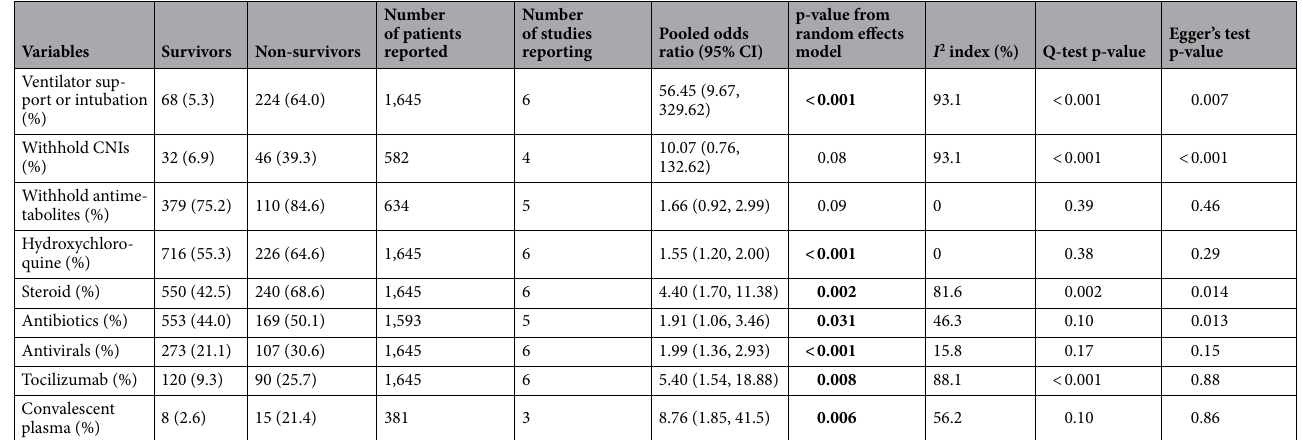
Table 4. Meta-analysis of treatment received between survivor and non-survivor kidney transplantation patients. CNI; calcineurin